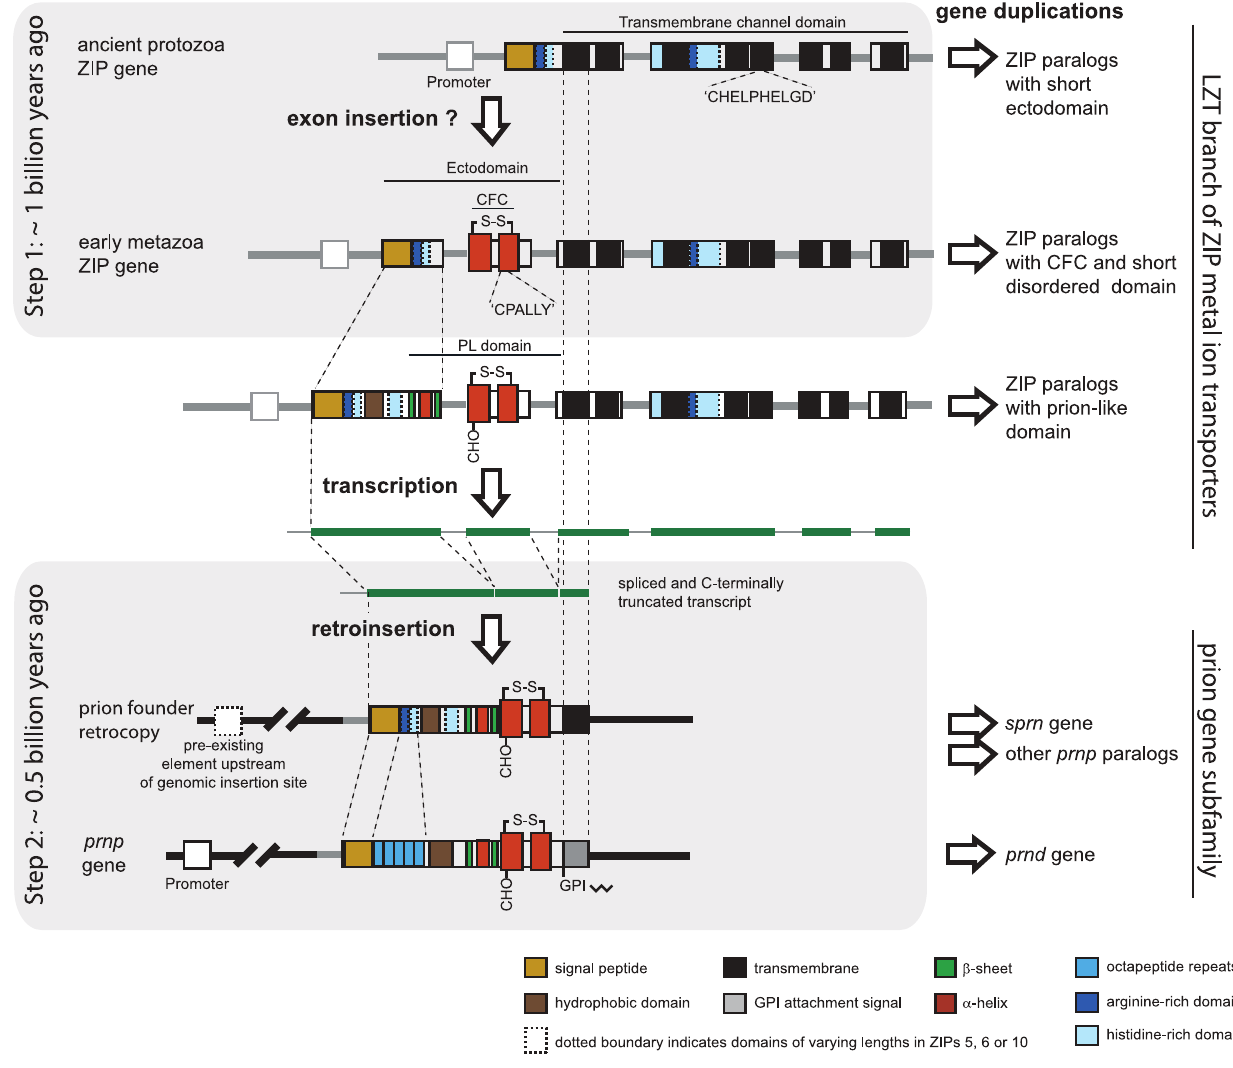
Figure 6. Two-step model of emergence of prion gene from a ZIP ancestor. At the time in evolution when early metazoa emerged, a CFC domain was inserted into an ancient ZIP transporter or evolved de novo . During early vertebrate speciation, a descendant of this ZIP ancestor, with ectodomain features resembling present-day ZIPs 5, 6 and 10, gave rise to a processed transcript which was reverse-transcribed and inserted into a genomic region that shares no synteny relationship with the parent gene. Through acquisition of a nearby 5 9 promoter element, this retrocopy may have evolved into a fully functional retrogene – the first prion gene. An additional expansion of the subfamilies of LZT and prion genes occurred through gene duplication events. Genomic elements in this figure are not drawn to scale. The depiction of intron positions for the ZIP gene are based on the intron-exon structure of the Trichoplax adhaerens LIV-1 ZIP gene harboring a CFC domain described in this manuscript.